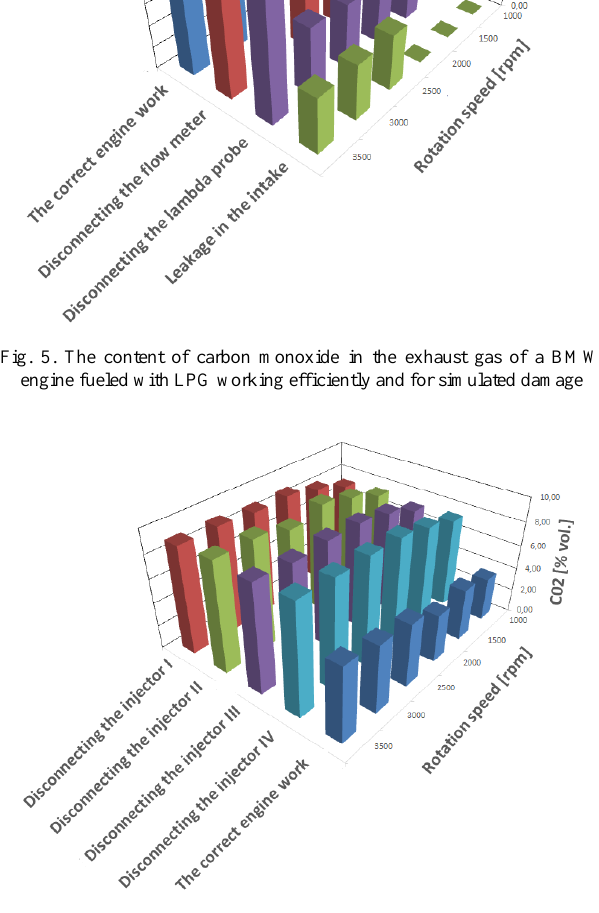
Fig. 3. The content of carbon monoxide in the exhaust gas of a BMW Fig. 6. Carbon dioxide content in the exhaust gas of a BMW engine fueled engine fueled with petrol and in the without ignition in individual cylin- with petrol and in the without ignition in individual ders